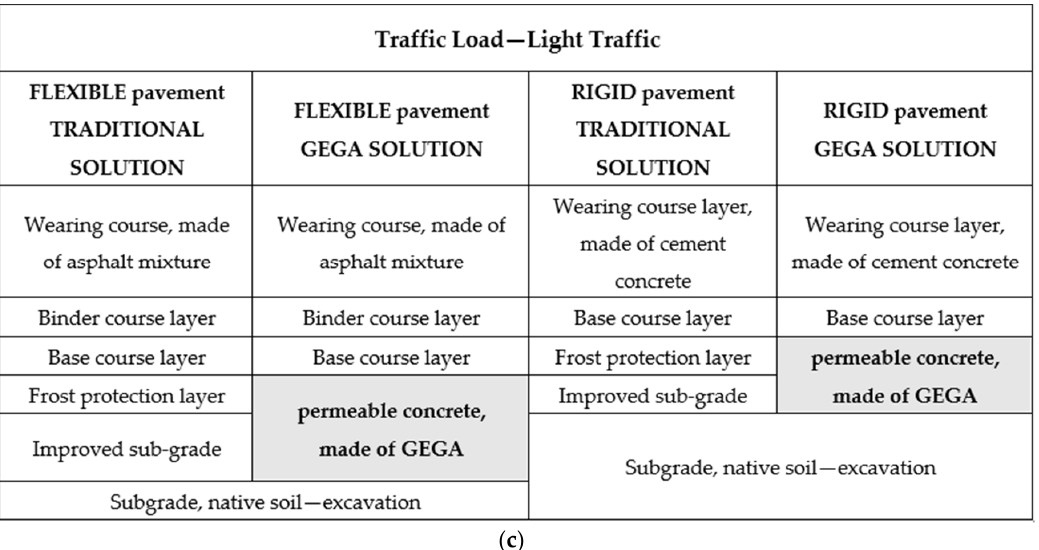
Figure 1. Structure of road layers design for flexible and rigid pavements—traditional and with the use of permeable concrete, made of GEGA for tra ffi c load: ( a ) heavy tra ffi c, ( b ) medium tra ffi c, and ( c ) light tra ffi